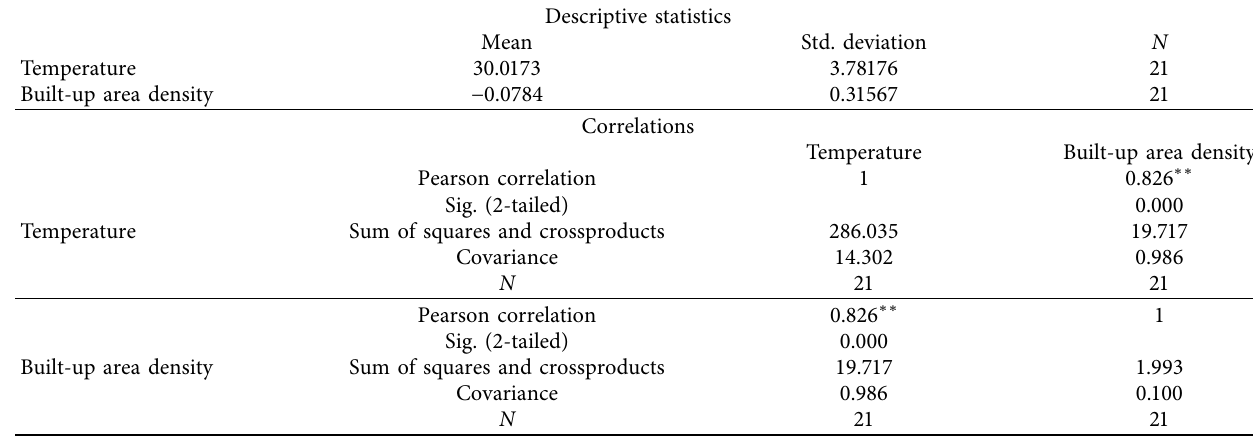
Table 5: Te correlation between surface temperature and built-up area density in Banjarmasin City in 2015.